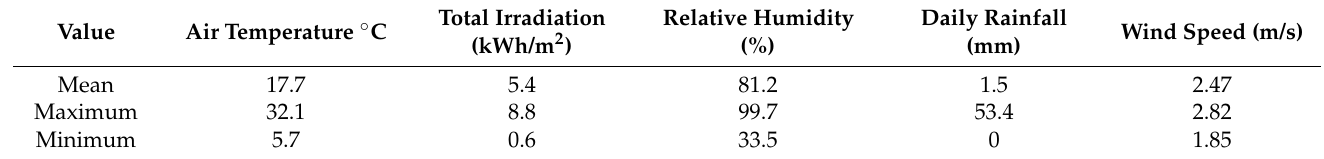
Table 4. Mean, minimum, and maximum values of weather conditions during exposure period time at the seaside site. Value Air Temperature ◦